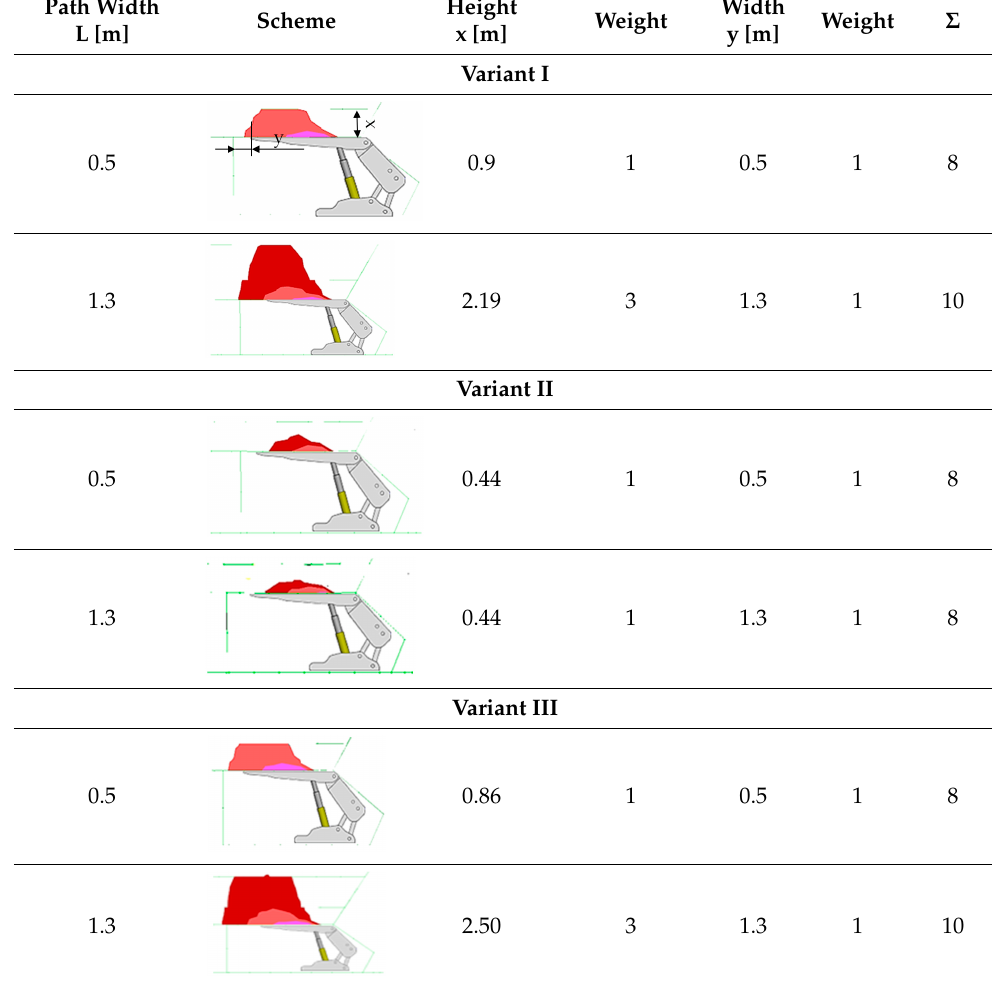
Table 7. Classification of rock falls occurring in the longwall workings under the influence of mining activity. Height Path Width Weight Scheme x [m] L [m]